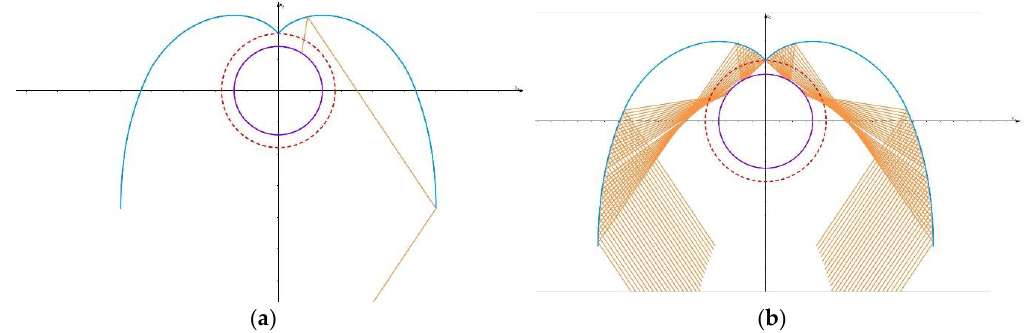
Figure 13. Ray-tracing in the CPC. ( a ) Incidence of the ray of light reflected at the end by the last mirror. ( b ) Tracing rays of the rays coming from the last mirror.